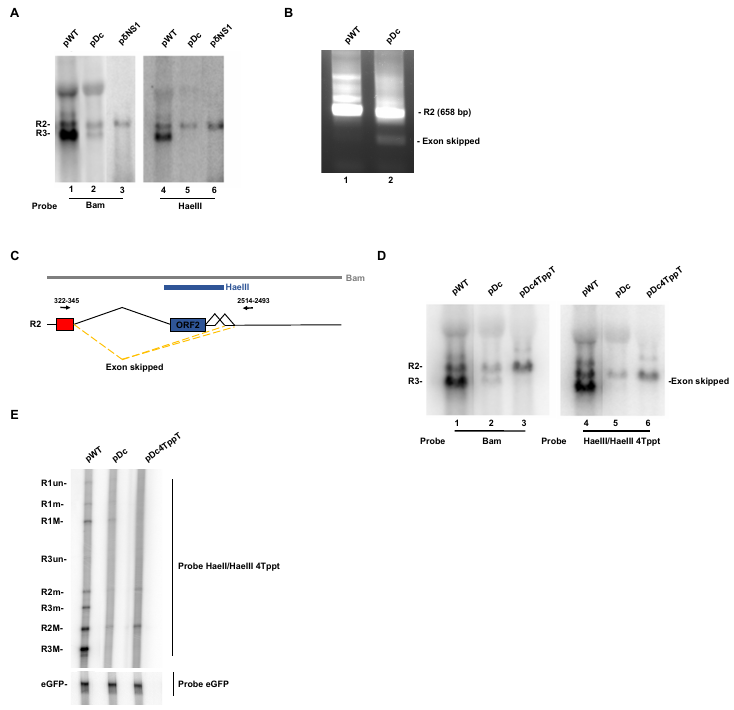
Figure 4. CTCF-binding site mutants resulted in skipping of the NS2-specific exon and joining of the large intron donor to the small intron acceptors, which can be overcome by mutations that improve the polypyrimidine tract of the upstream large intron. ( A ) Human NB324K cells, transfected with the indicated plasmids, were harvested at 48 hpt and total RNA was isolated using TRIzol reagent. Samples were processed for Northern blot analysis using the probes indicated at the bottom of the panel. The identity of the viral RNA species is shown on the left. ( B ) Total RNA extracted from NB324K cells, transfected with the WT or the double CTCF-binding site mutant, was subjected to DNase I treatment for 1 h at 37 ◦ C. First-strand cDNA synthesis was performed on the DNase I-treated RNA samples and the cDNA product was used as a template for downstream PCR analysis as described in Materials and Methods. The identities of the amplified bands were determined by sequencing analysis and are shown to the right. ( C ) Schematic representation of R2 (top) and the exon-kipped product (bottom), generated from the double CTCF-binding site mutant construct. The exon-skipped product skips the NS2-specific exon (ORF2) and joins the large intron donor at nt 514 to the small intron acceptor A1 (nt 2377) or A2 (nt 2399). The PCR primers used to detect the exon-skipped product are indicated at the top of the panel (black arrows). The numbers on top of the arrows represent the location on the viral genome where the primers anneal. Approximate locations of the RNase protection viral probes (Bam and HaeIII) are also indicated. Total RNA extracted from NB324K cells, transfected with the indicated plasmids as well as eGFP, was subjected to Northern blot analysis ( D ) or RNase protection assay ( E ) as described in Materials and Methods using the probes shown at the bottom ( D ) or to the right ( E ) of the panel. The identity of the RNA species are also